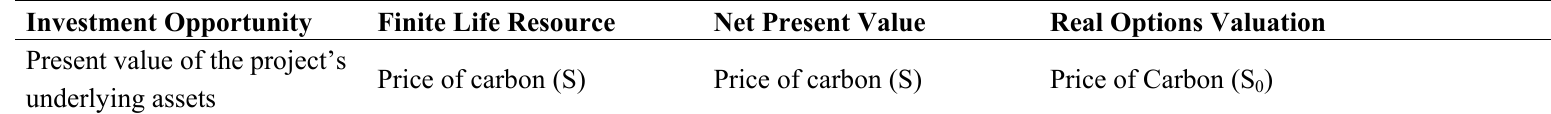
Table 3. Comparison of three valuation